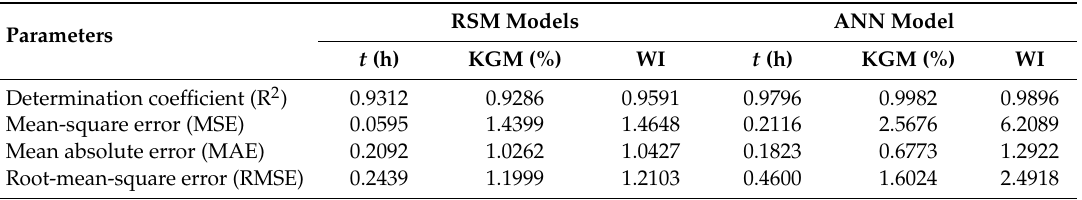
Figure 10. The comparison of experimental values and predicting results for the t ( a ), KMG ( b ) and WI ( c ). RSM: response surface methodology. Table 6. Statistical parameters for comparing RSM and ANN models.